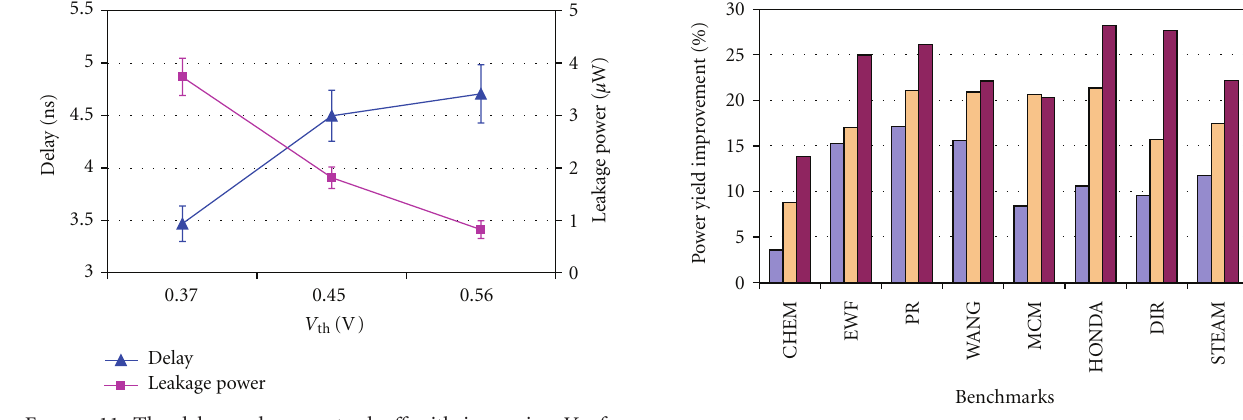
Figure 11: The delay and power tradeo ff with increasing V th for bkung with default device sizing (1W1L).